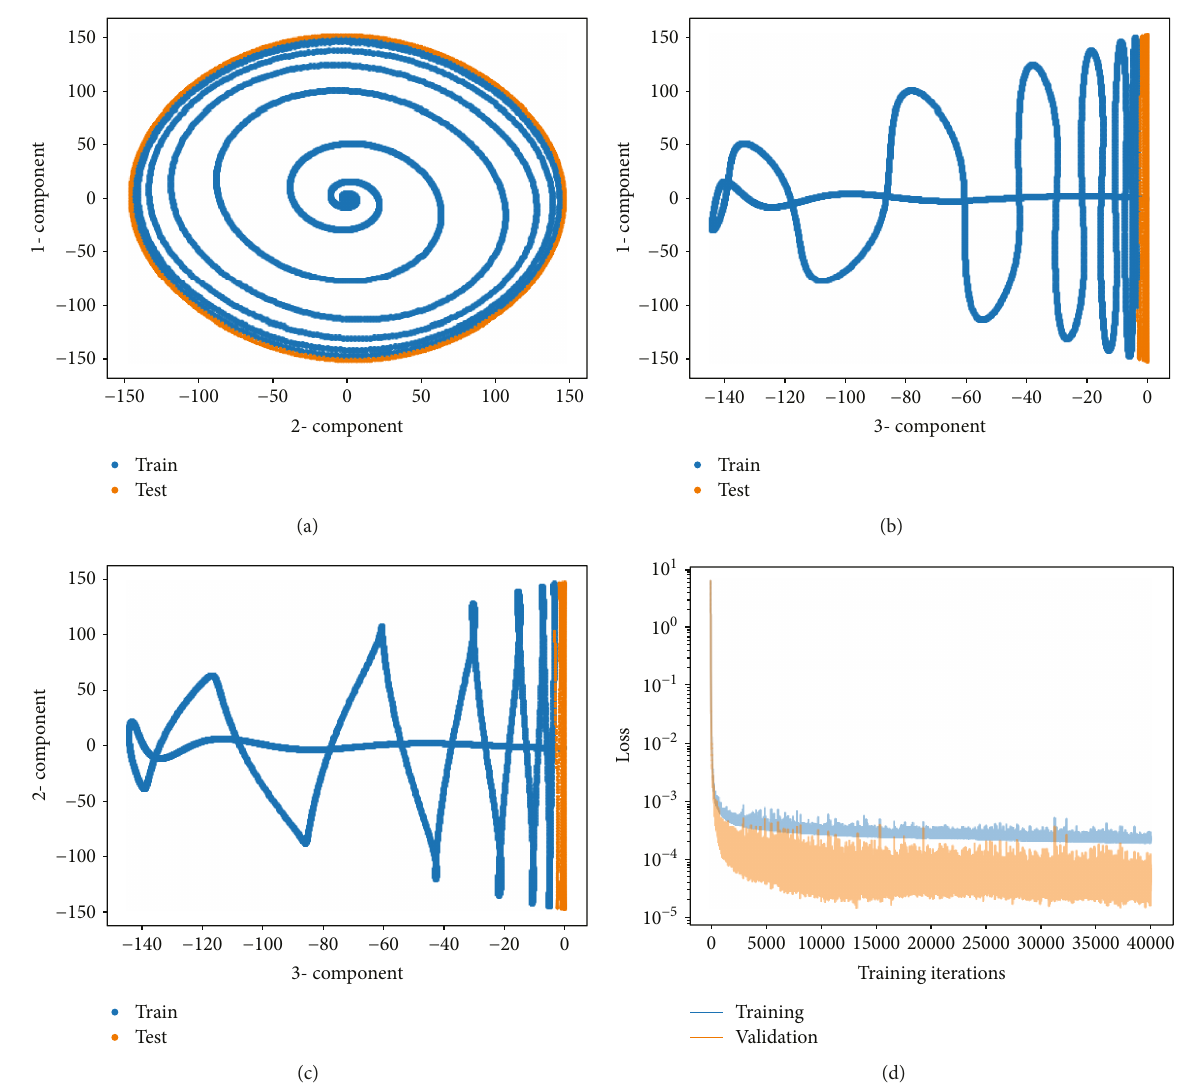
Figure 13: Flow in a cylinder wake. (a) Data distribution of x (d) Learning curve.